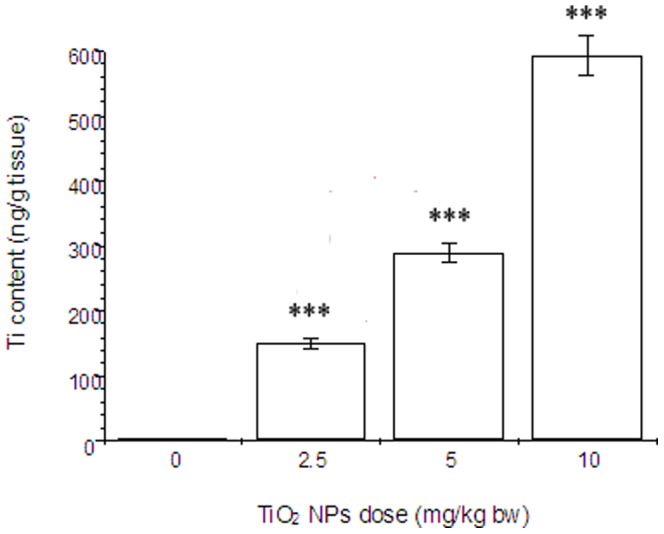
The content of titanium in mouse hippocampus following nasal administration of TiO2 NPs for 90 consecutive days.Bars marked with three asterisks means it is significantly different from the control (unexposed mice) at the 0.1% confidence level, respectively. Values represent means ± SD (N  = 5).